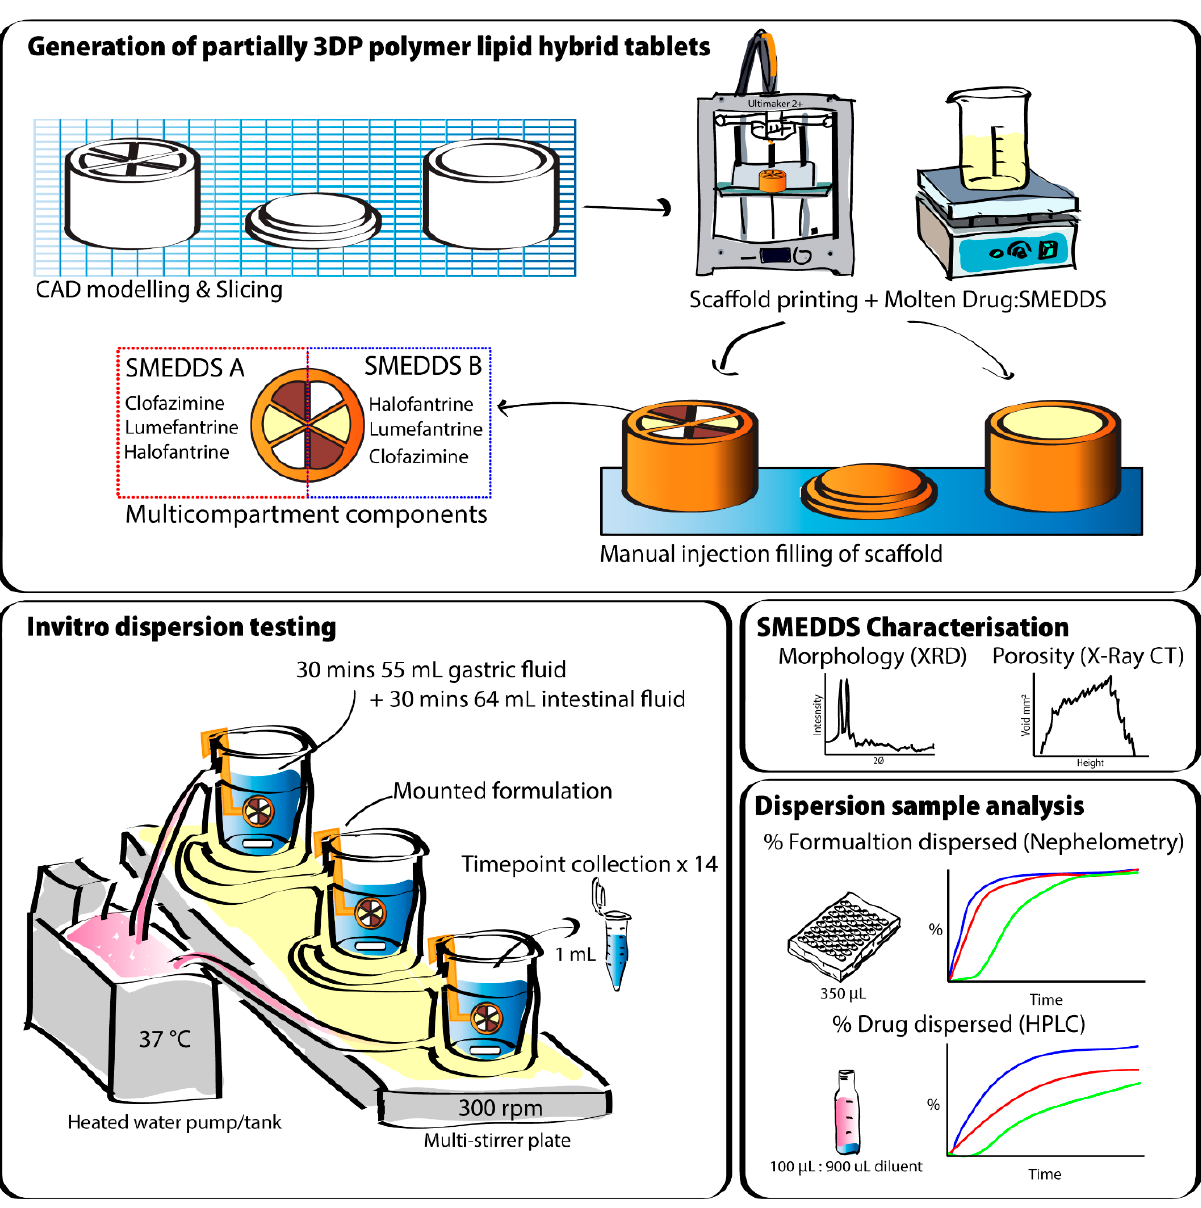
Figure 1. Schematic displaying the general approach to prepare and investigate the polymer–lipid hybrid tablets. In the top panel, the printing of single- and multicompartment scaffolds is illustrated. The bottom panels illustrate the dispersion and release methodologies and analytical techniques.